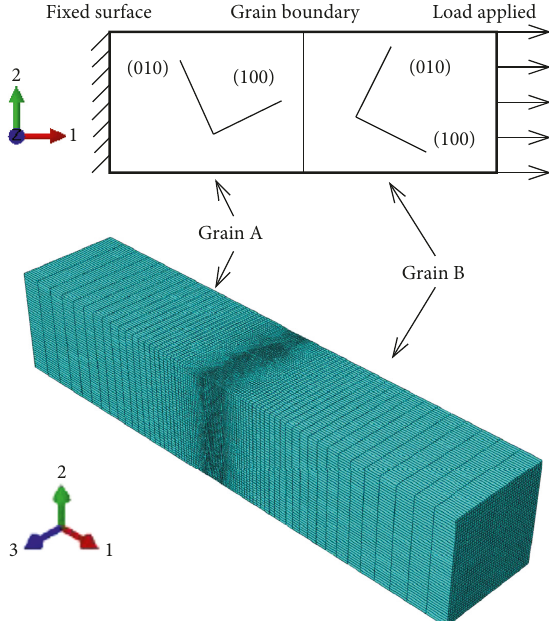
Figure 3: Type I GB perpendicular to tensile